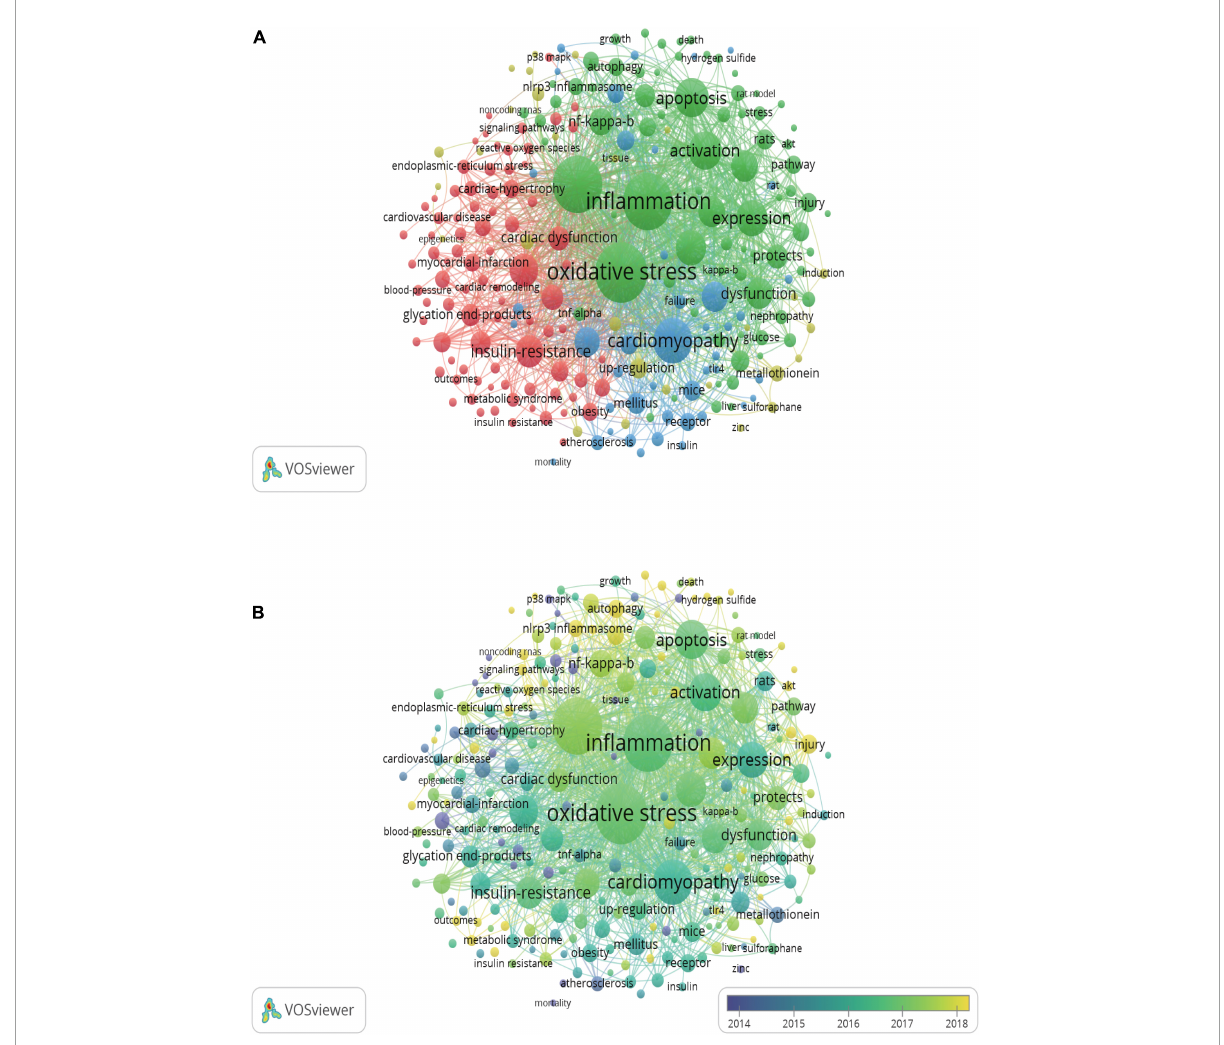
FIGURE5 Network map of co-occurrence analysis of all keywords. (A) Mapping of keywords of publications. (B) Distribution of keywords according to average publication year. The analysis method was Linlog/modularity in VOSviewer, the weight was an occurrence, and scores were the average published